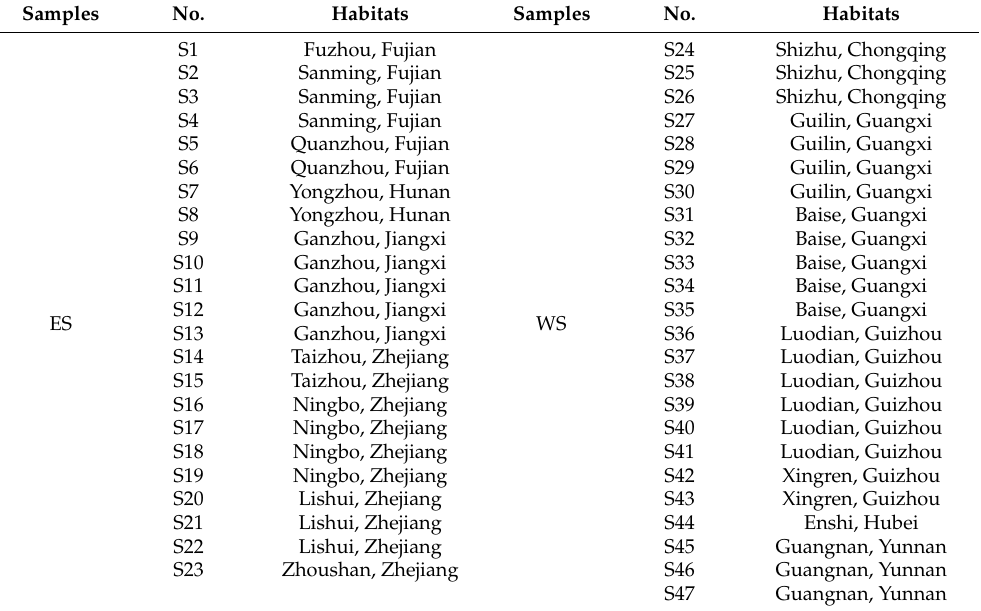
Table 4. Information of ES and